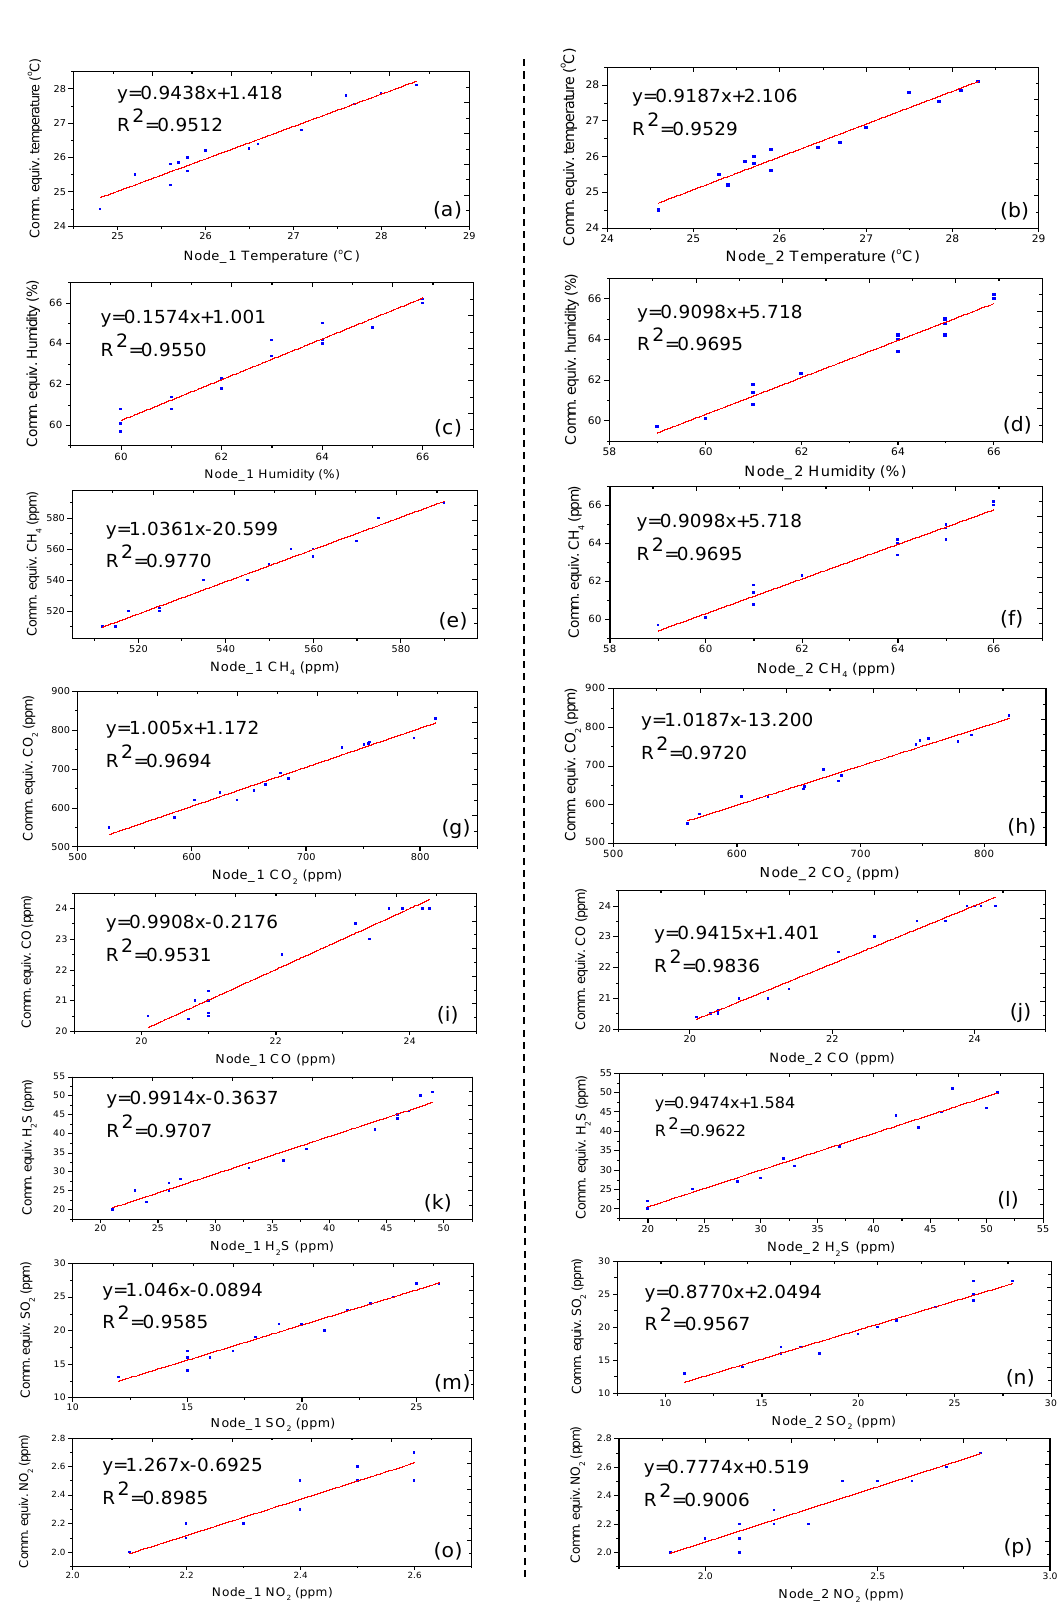
Figure 6. Correlation and regression plots of sensor nodes 1 and 2 for the attached sensor modules, ( a , b ) temperature, ( c , d ) humidity, ( e , f ) CH 4 , ( g , h ) CO 2 , ( i , j ) CO, ( k , l ) H 2 S, ( m , n ) SO 2 , and ( o , p ) NO 2 , in comparison to their commercial equivalents.